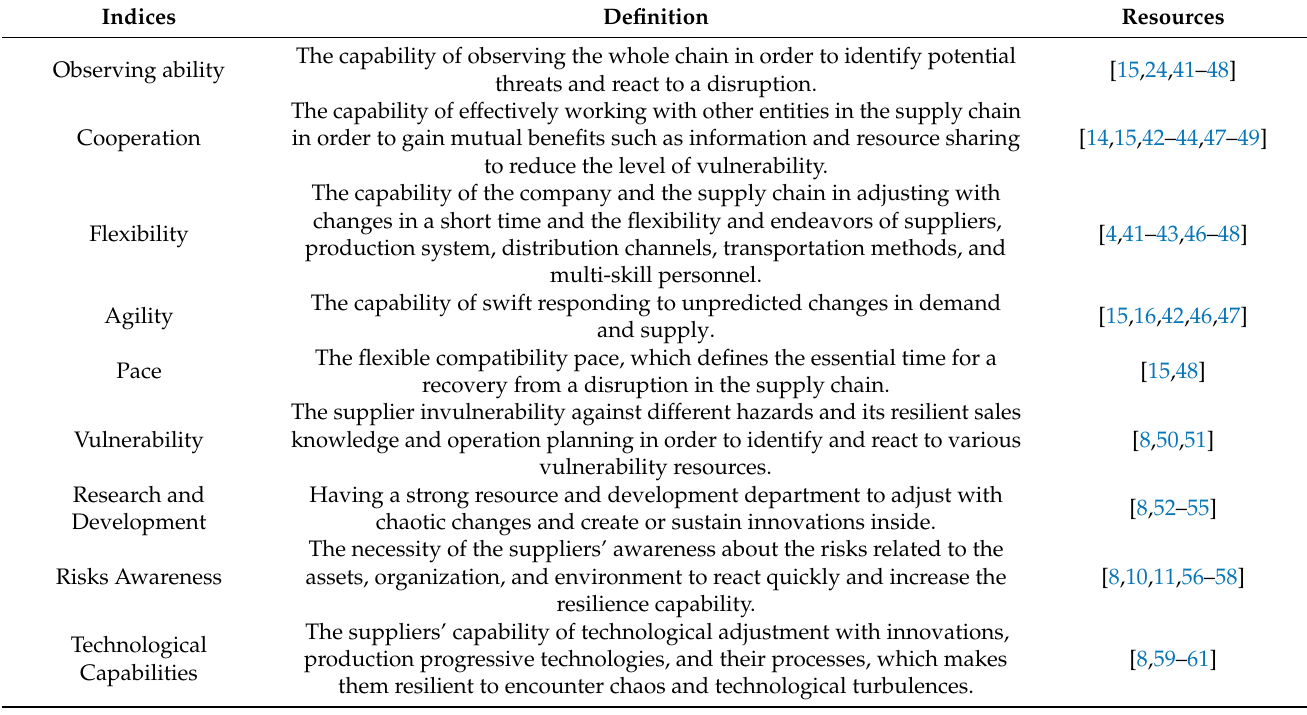
Table 1. Suppliers’ resilience evaluation